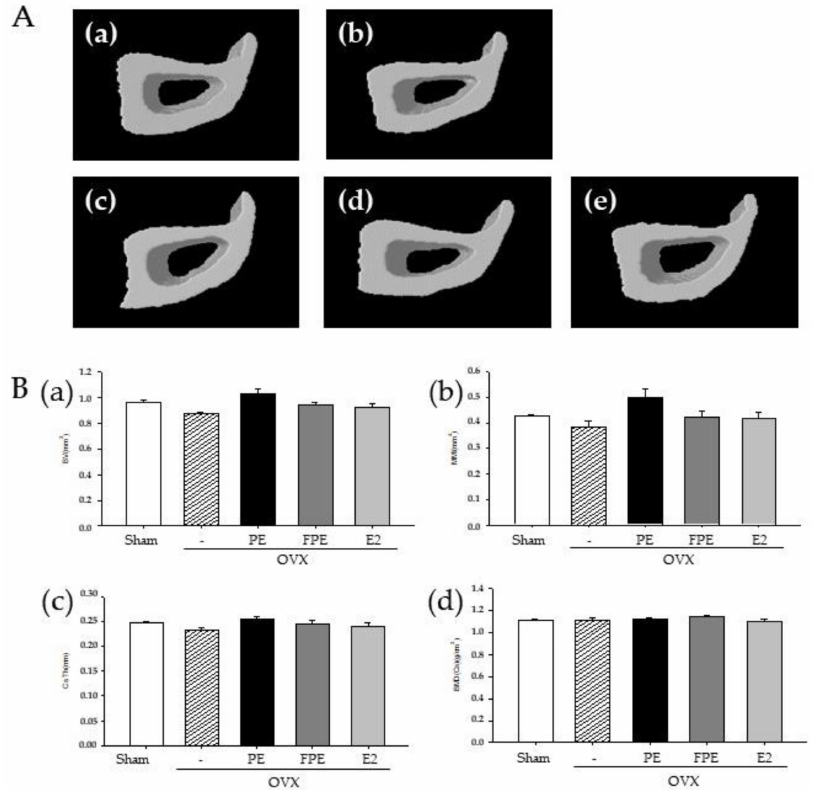
Figure 7. Micro-CT analysis of the cortical bone. ( A ) Micro-CT images of the cortical bone of the